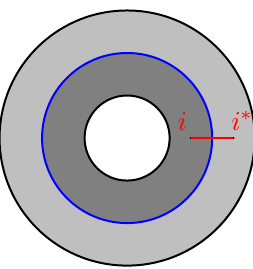
Figure 14 . (Color online) Constant time slice of the eternal BTZ black hole as in (cid:12)gure 5. The Wilson line corresponding to the quasiparticle-antiquasiparticle pair i , i (cid:3) intersects with horizon both on the constant time slice and in the 3d